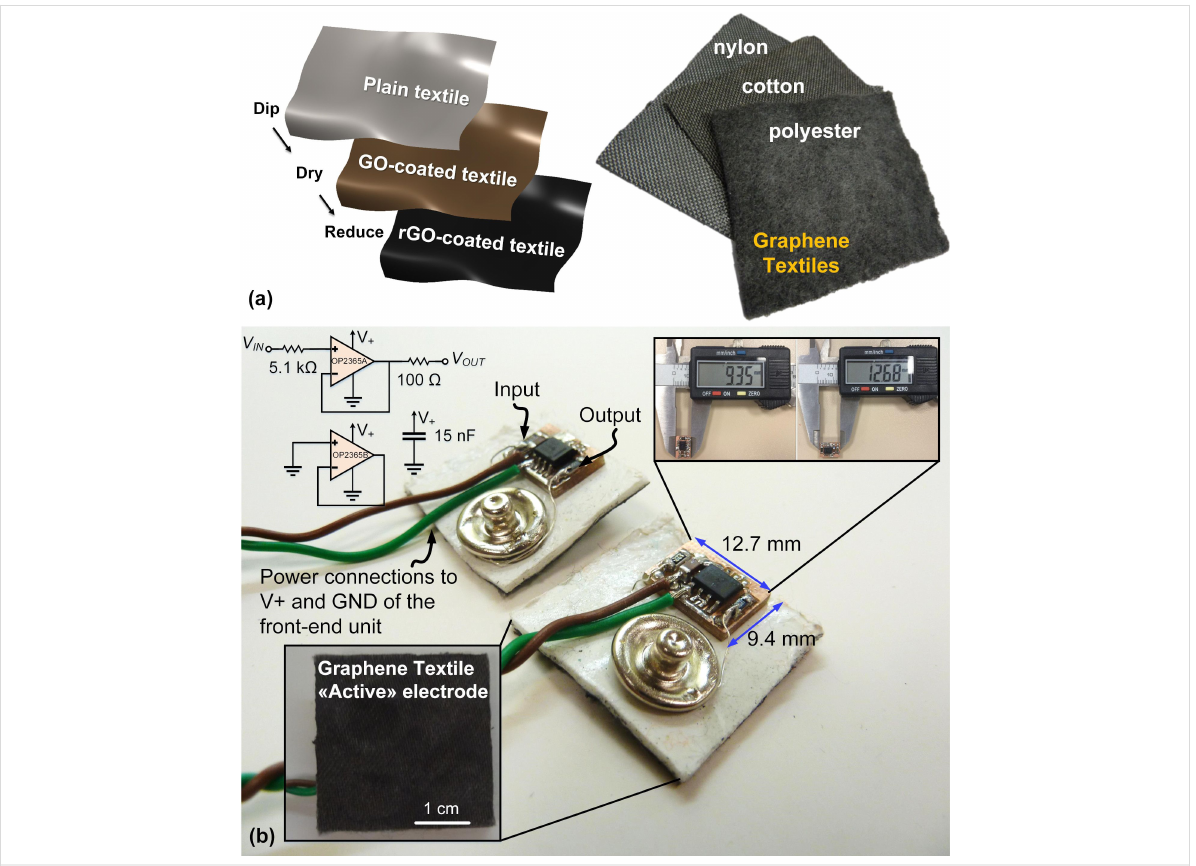
Figure 1: (a) Schematic of the three-step process to obtain conformal graphene coatings on a variety of textiles including nylon, cotton, and polyester; (b) image of the graphene textile “active” electrode with integrated buffer circuitry along with component values and circuit schematic. V in is connected to the graphene textile, and V out is connected to the snap button. Both are used to provide the connection of the “active” textile electrode to the signal acquisition unit; insets show the front side of the electrode assembly with the graphene textile and the dimensions of the miniaturized-PCB on the rear side of the